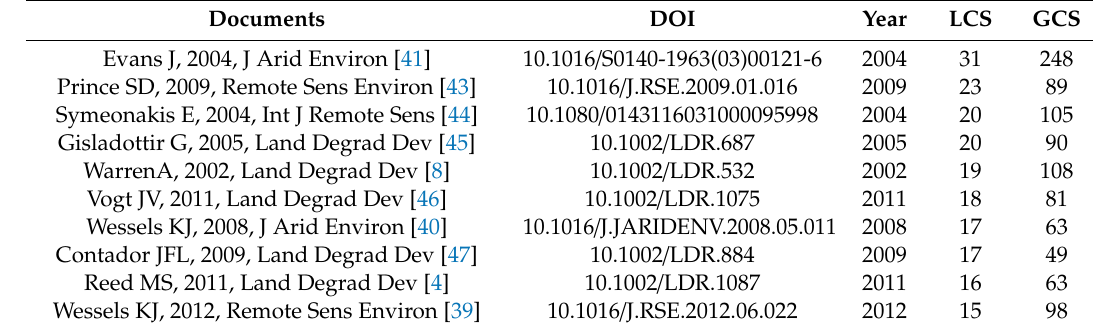
Table 1. Top 10 local citation scores (LCS) in land-degradation research.